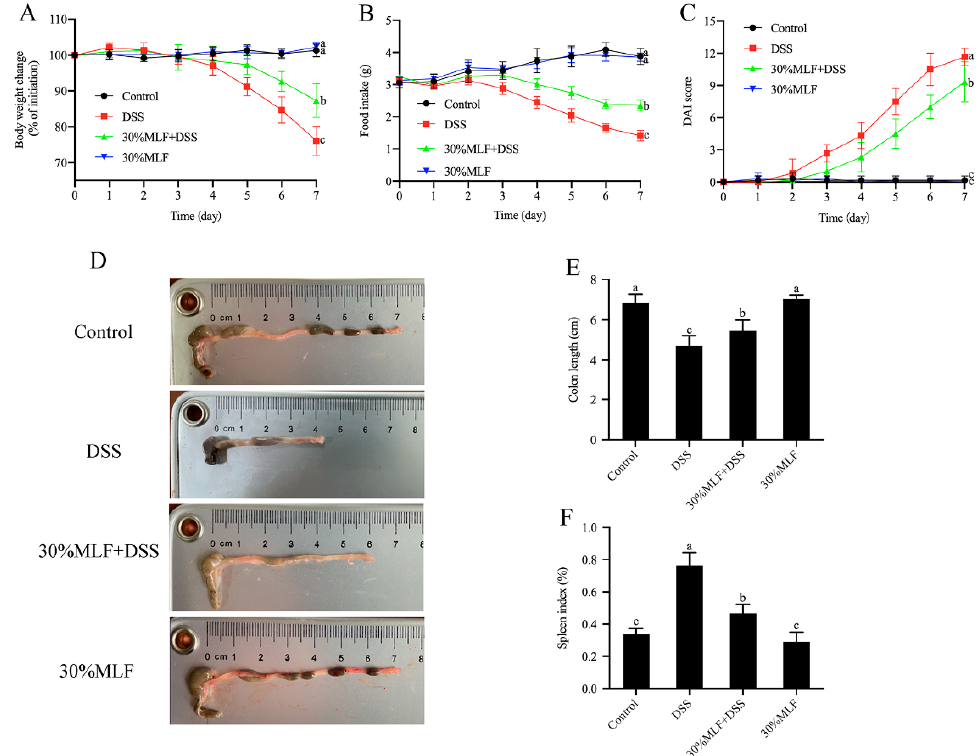
Figure 7. Effect of 30%MLF on the clinical symptoms of mice in DSS-induced ulcerative colitis: ( A ) body weight change and ( B ) food intake. ( C ) DAI. ( D ) Representative pictures of the macroscopic appearance of the colon length and ( E ) the statistical results. ( F ) Spleen index. Data are presented as the means ± SD ( n = 6). Columns with different superscript letters indicate significant differences ( p < 0.05).